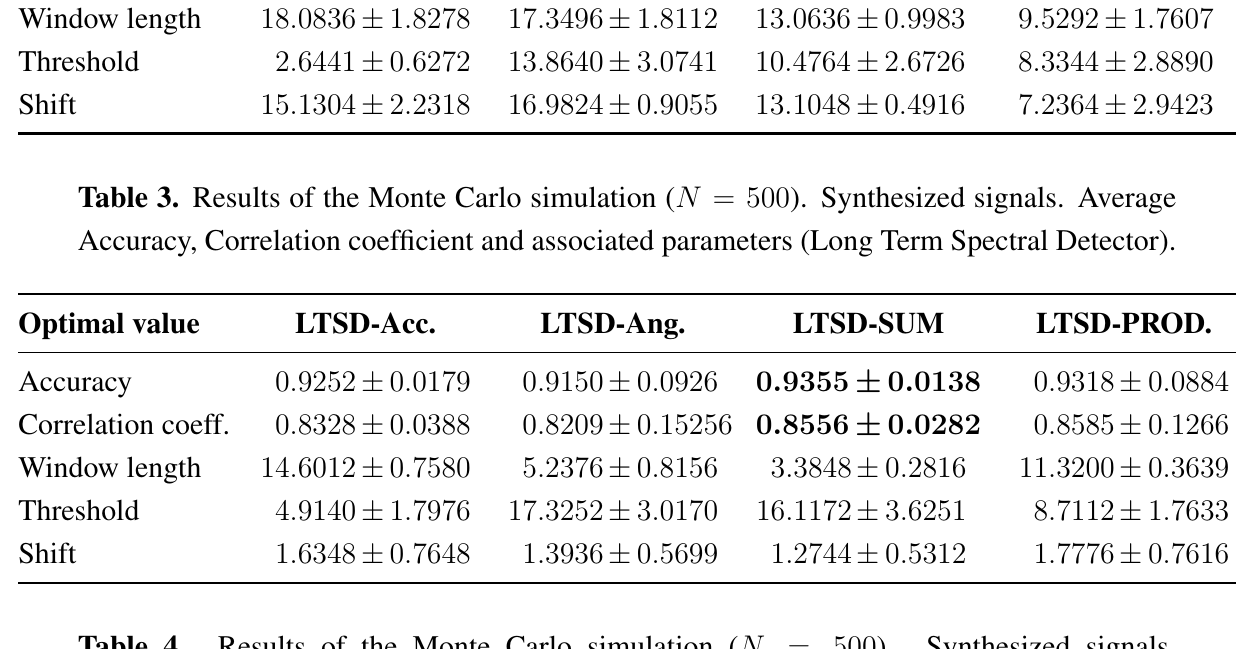
Table 4. Results of the Monte Carlo simulation ( N = 500 ). Synthesized signals. Average Accuracy, Correlation coefficient and associated parameters (Memory Based Graph Theoretic